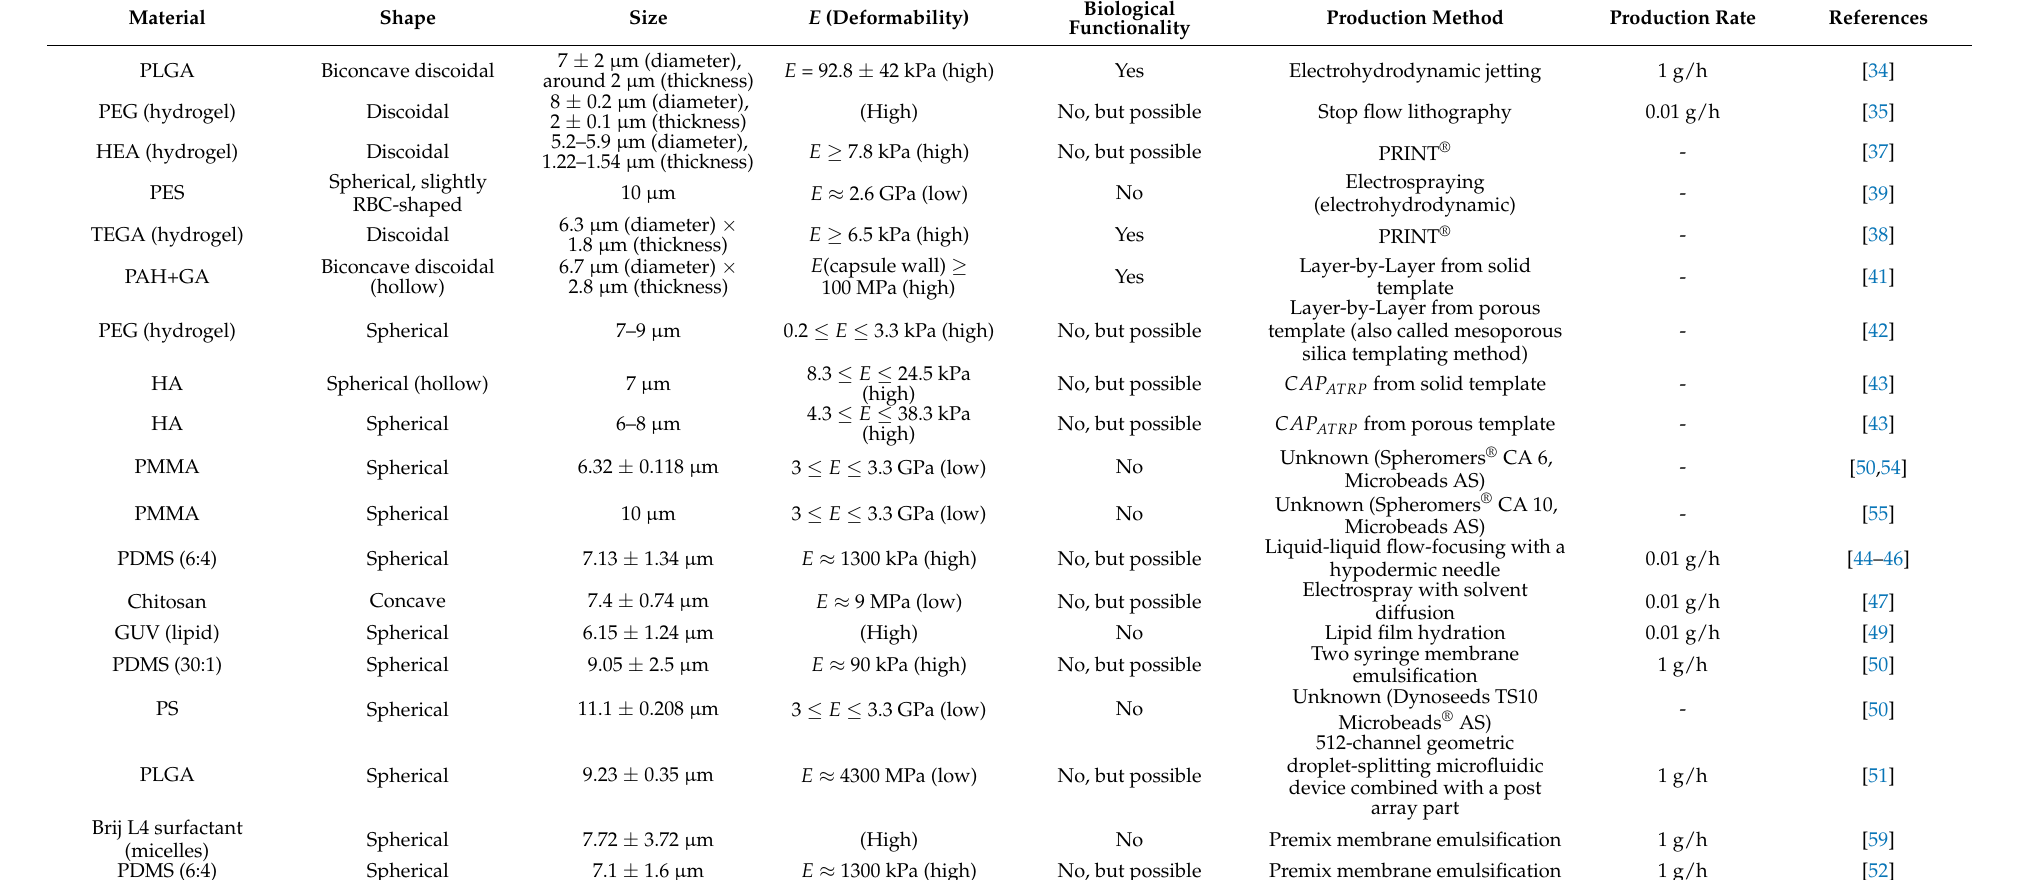
Table 1. Summary of RBC templates used in the